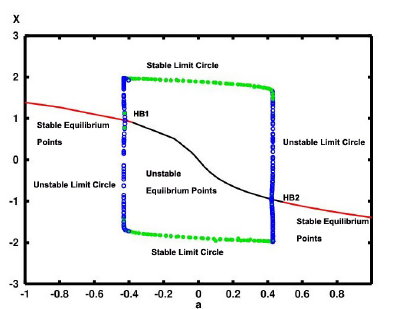
Figure 40. One-parameter bifurcation of re- covery variable concerning the external ap- plied current with parameters a = 0.8 , b = 0.7 & c = 3 . Stable (green filled circles) and unsta- ble (blue vacant circles) branches of periodic solution of the BVP model showing di ff erent dynamical behavior.